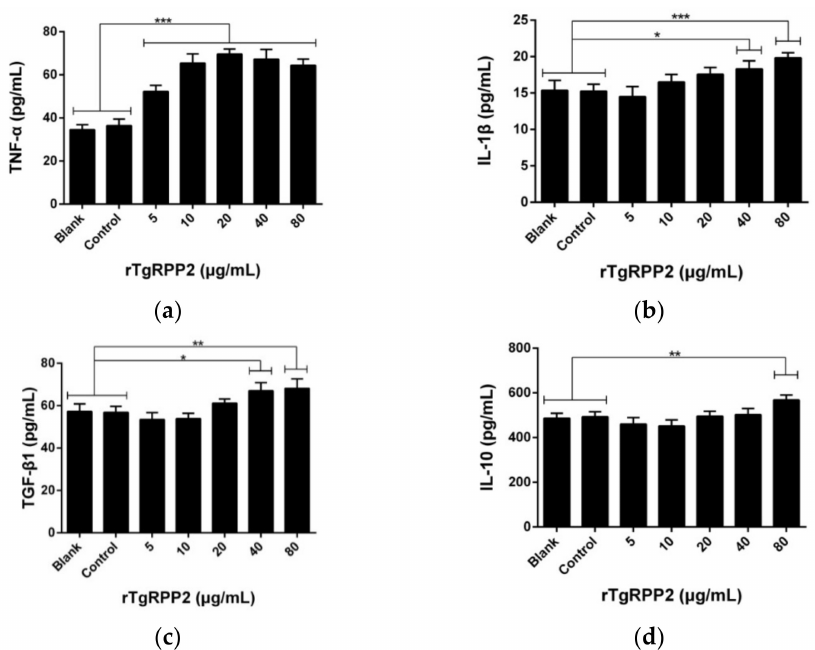
Figure 7. Effect of recombinant TgRPP2 on tumor necrosis factor- α (TNF- α ) ( a ), interleukin-1 β (IL-1 β ) ( b ), transforming growth factor- β 1 (TGF- β 1) ( c ), and interleukin-10 (IL-10) ( d ) secretion of murine Ana-1 cells. The Ana-1 cells were preincubated with rTgRPP2 at different concentrations for 48 h, and the cytokine secretion was then measured by ELISA kits. Values were evaluated using one-way ANOVA analysis, followed by Dunnett’s test, and presented as the mean ± standard deviation of three independent experiments ( n = 3). * p < 0.05, ** p < 0.01, and *** p < 0.001 compared with the blank group or the control group.